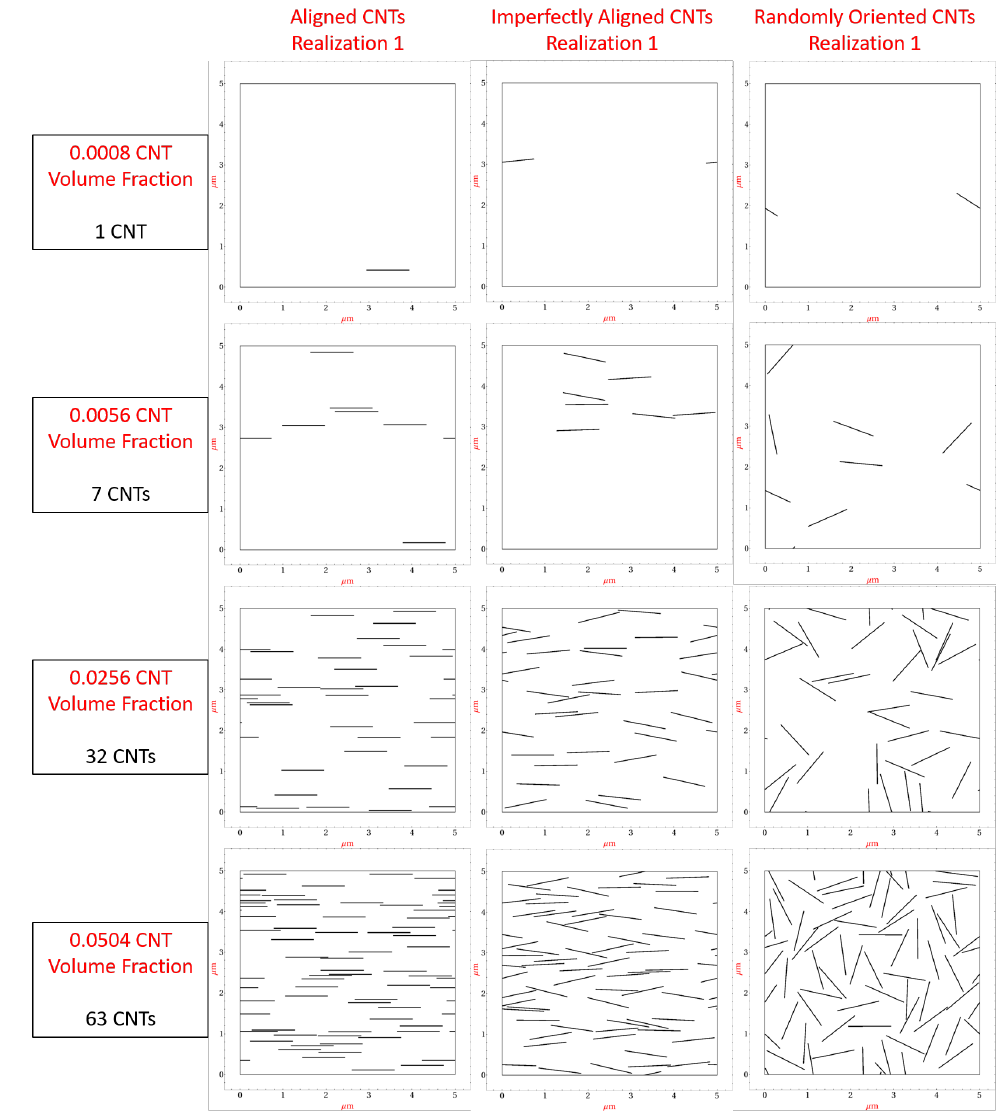
Figure 3. First realization generated for CNT volume fractions 0.08%, 0.56%, 2.56% and 5.04% for the orientation conditions of aligned, imperfectly aligned and randomly oriented